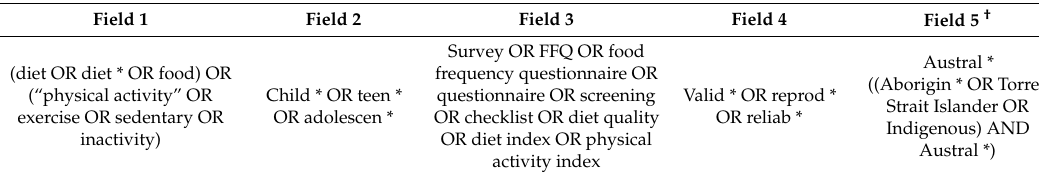
Table 4. Search terms